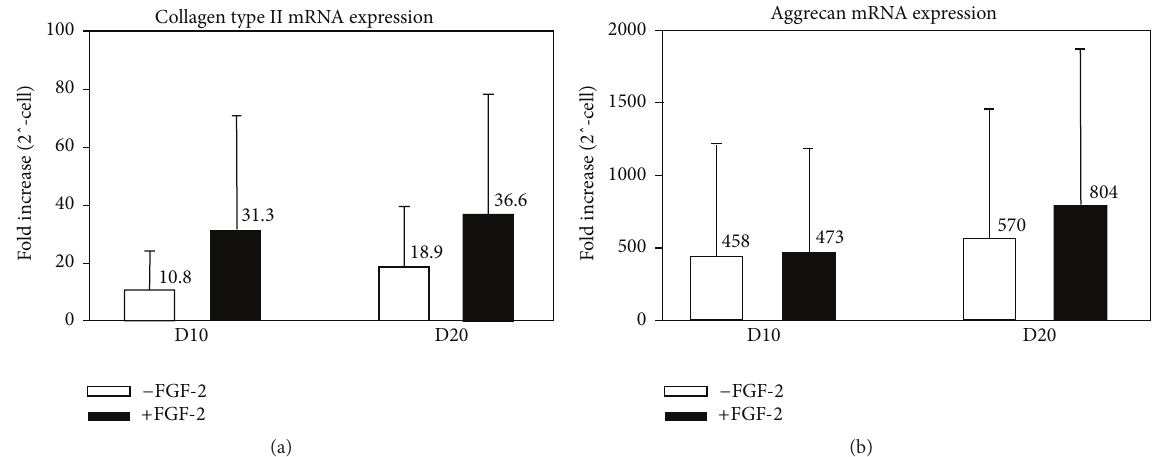
Figure 5: Collagen type II (a) and aggrecan (b) mRNA expression (fold increase) on days 10 and 20 of chondrogenic culture with (white) or without (black) FGF-2 supplementation ( 𝑛 = 5 ; 5).